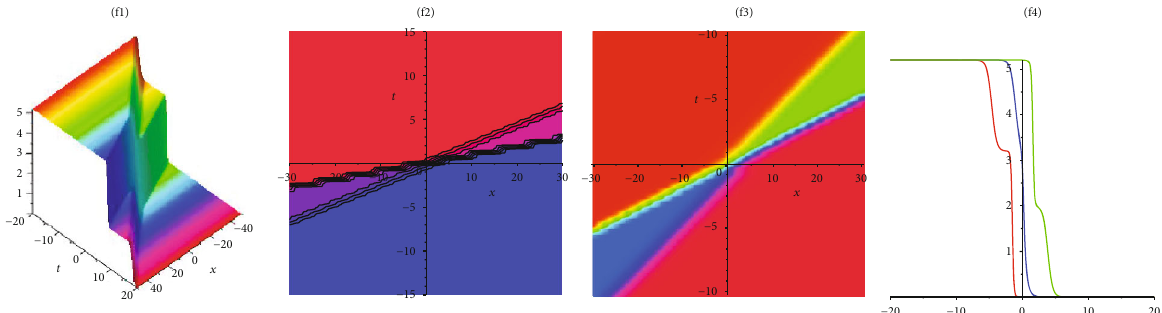
Figure 10: The one-wave solution (51) at α = 0 : 5, β = 0 : 1, α 1 : 5, δ = 2, and y = 1 3